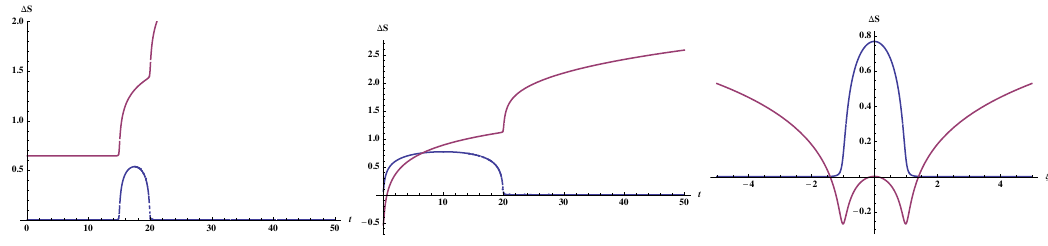
Figure 18 . The plots of the holographic entanglement entropy growth S A (cid:0) S (0) the holographic joining local quench. We set the tension vanishing T BCFT = 0. The blue and red curve describes S con